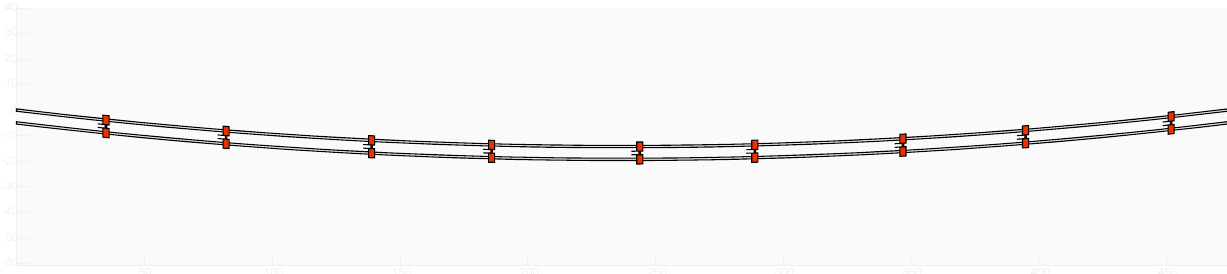
Figure 22. Schematization of the span modelled in ATTRA software.